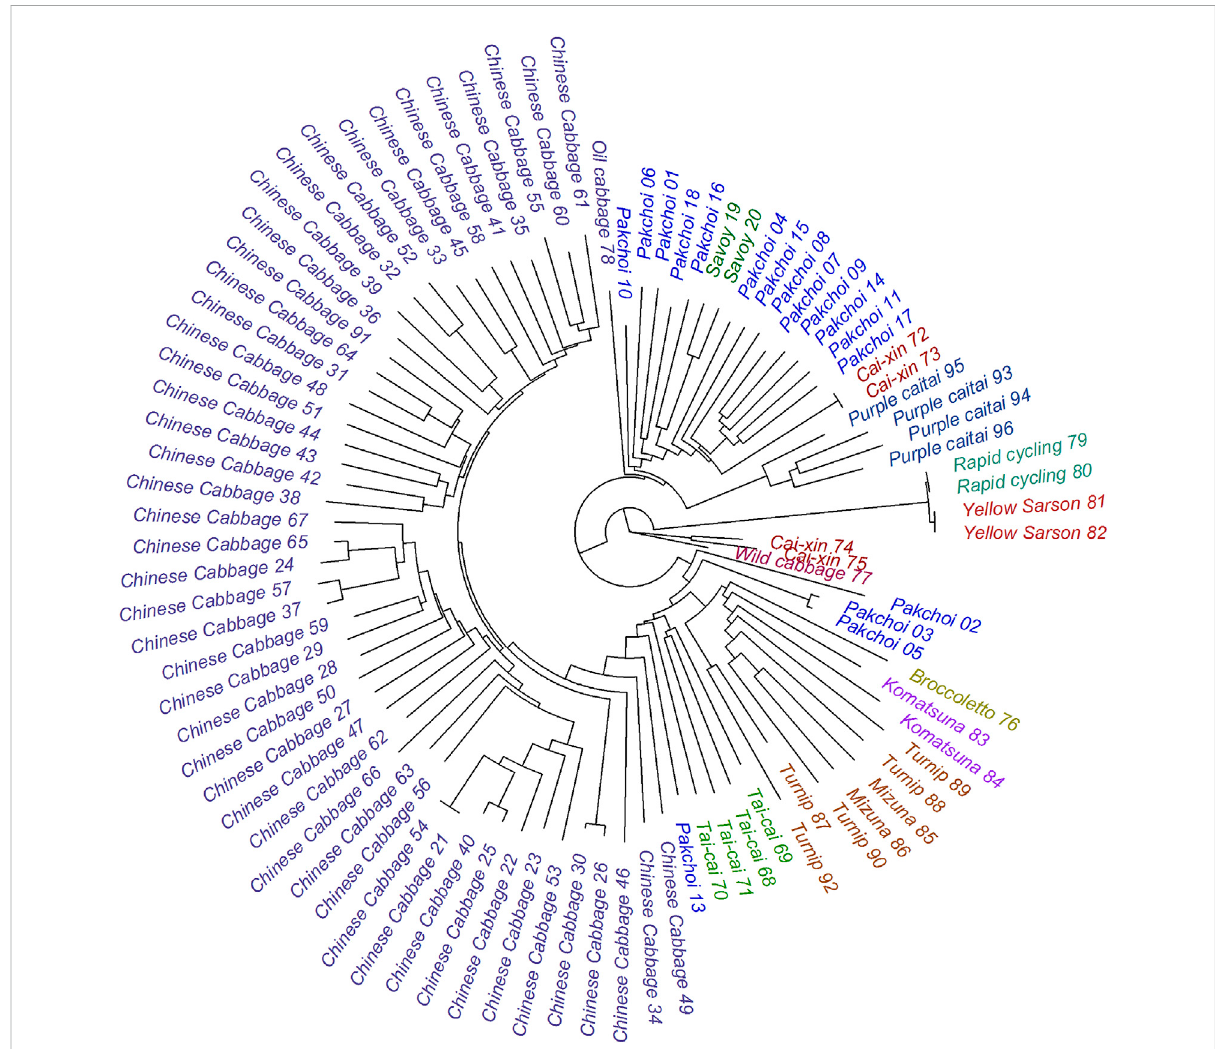
FIGURE 1 The phylogenetic distance tree of the 102 analyzed B. rapa accessions based on the DNA sequence variation — SNPs with MAF > 0.05 as described by Cheng et al. (2016). The tree is rooted in the wild-type cabbage genotype. Classi fi cation of the sub-species is represented by the color